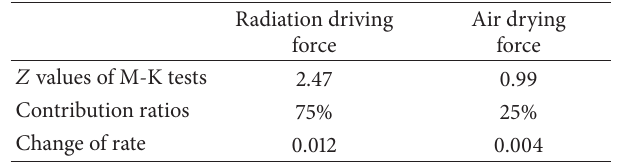
Table 2: 𝑍 values of the M-K trend tests for annually averaged net radiation, averaged air temperature, averaged relative humidity, and averaged wind velocity in Dongping Lake during 2003–2010.